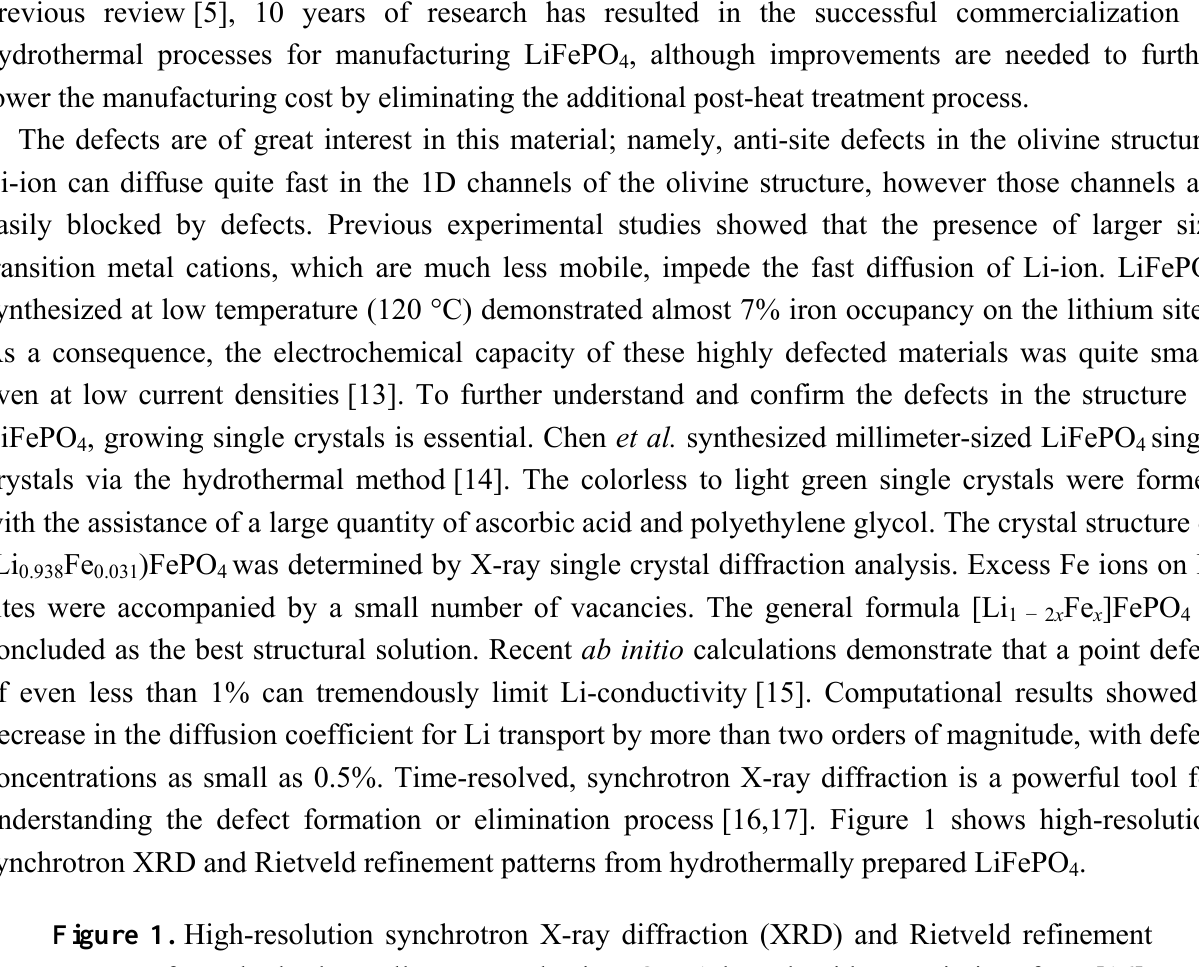
. Adapted with permission from 4